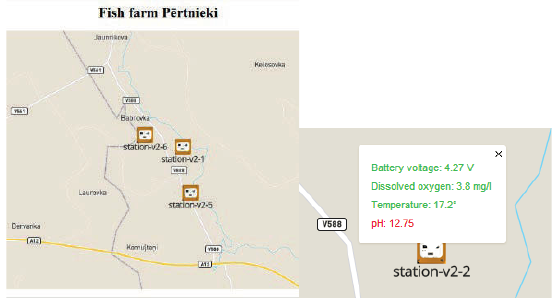
Fig. 7. The locations of nodes on the map with corresponding actual data.